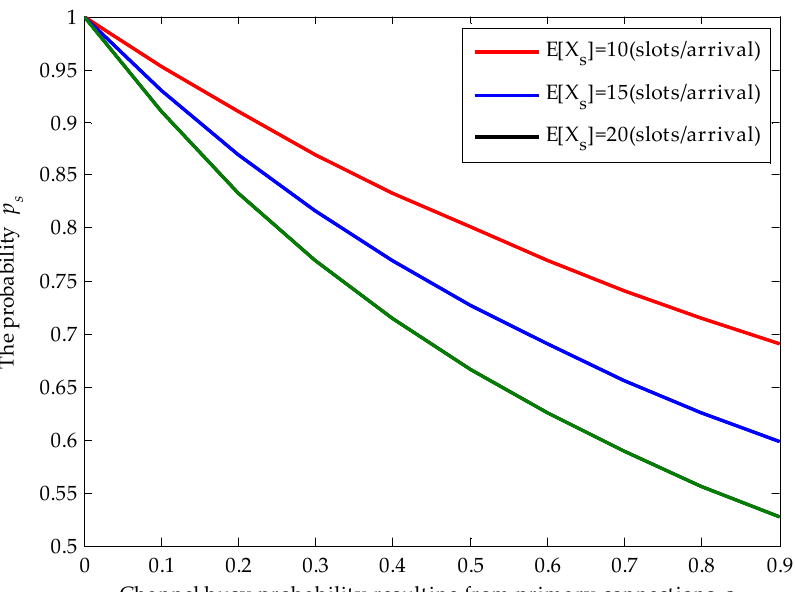
Figure 3. Effects of the channel busy probability ρ p resulting from primary connections and the average service time E r X s s of secondary connections on the probability p s , where E r X p s “ 20 (slots/arrival), λ s “ 0.01 (arrivals/slot), λ p “ 0.02 (arrivals/slot) and λ s E r X s s ` ρ p ă